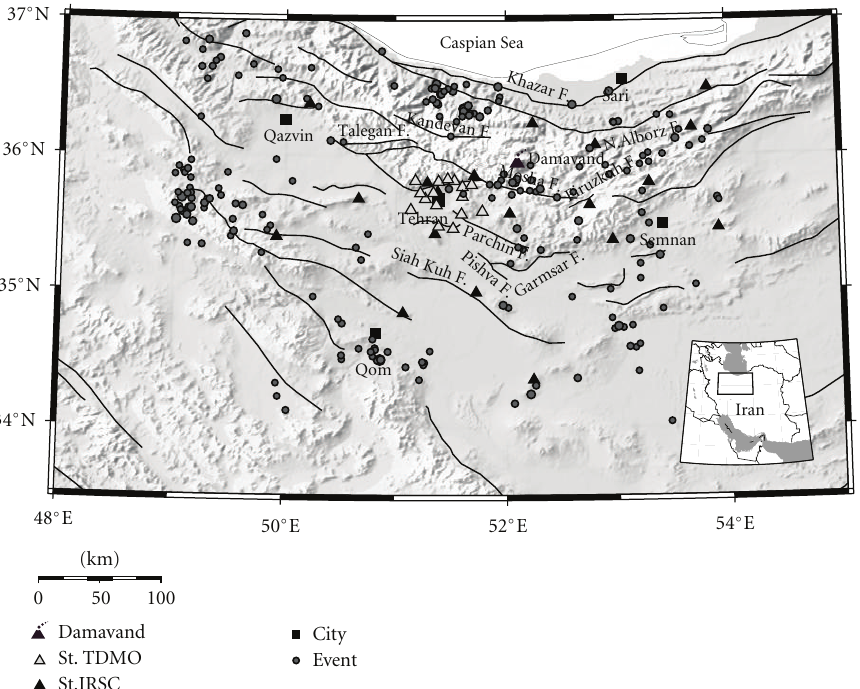
Figure 1: Topographic map of the study area accompanied with the distribution of recording stations and the earthquakes used for the study. Solid lines illustrate the major faults, rectangles represent significant cities, the circles show earthquake epicenters, and triangles indicate seismic